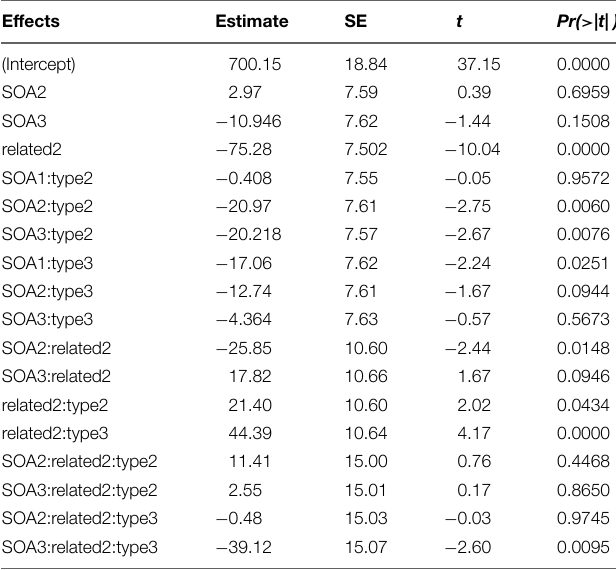
TABLE 6 | Summary of fixed effects in the linear mixed-effects model for onset latencies in Experiment 3.